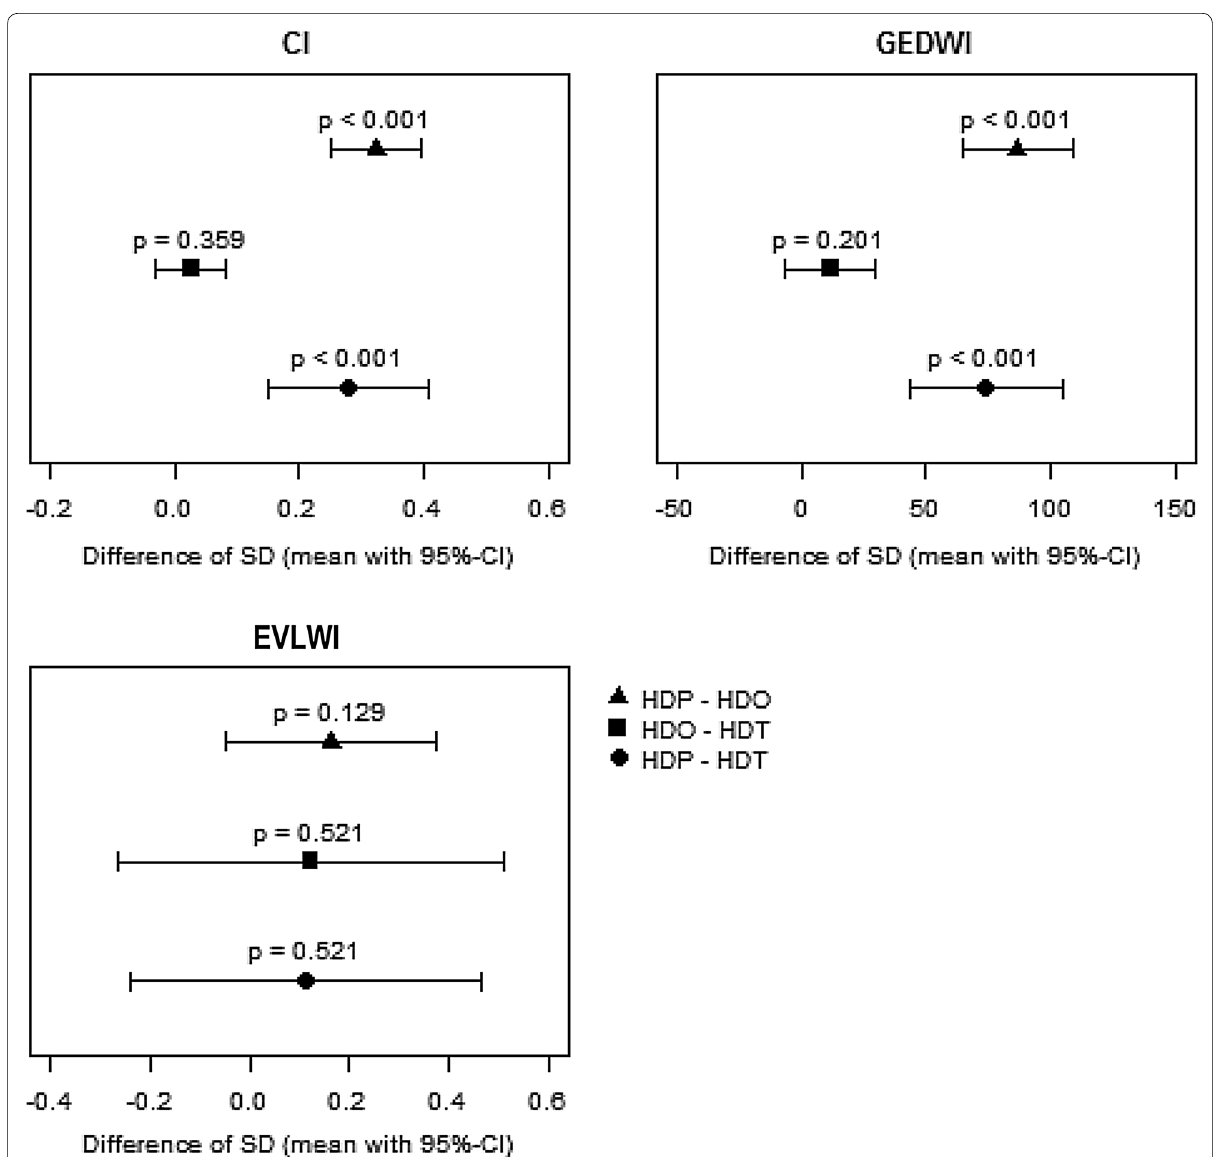
Fig. 1 Mean differences in SD for CI, GEDVI, EVLWI. Shown are the differences in SD (with confidence intervals) between the triplicate measurements for the parameters cardiac index (CI) ( a ), global end-diastolic volume index (GEDVI) ( b ) and extravascular lung water index (EVLWI) ( c ) for paused versus during (HDP/HDO) (filled triangle), during versus stopped (HDO/HDT) (filled square) and paused versus stopped HD (HDP/HDT) (filled circle)